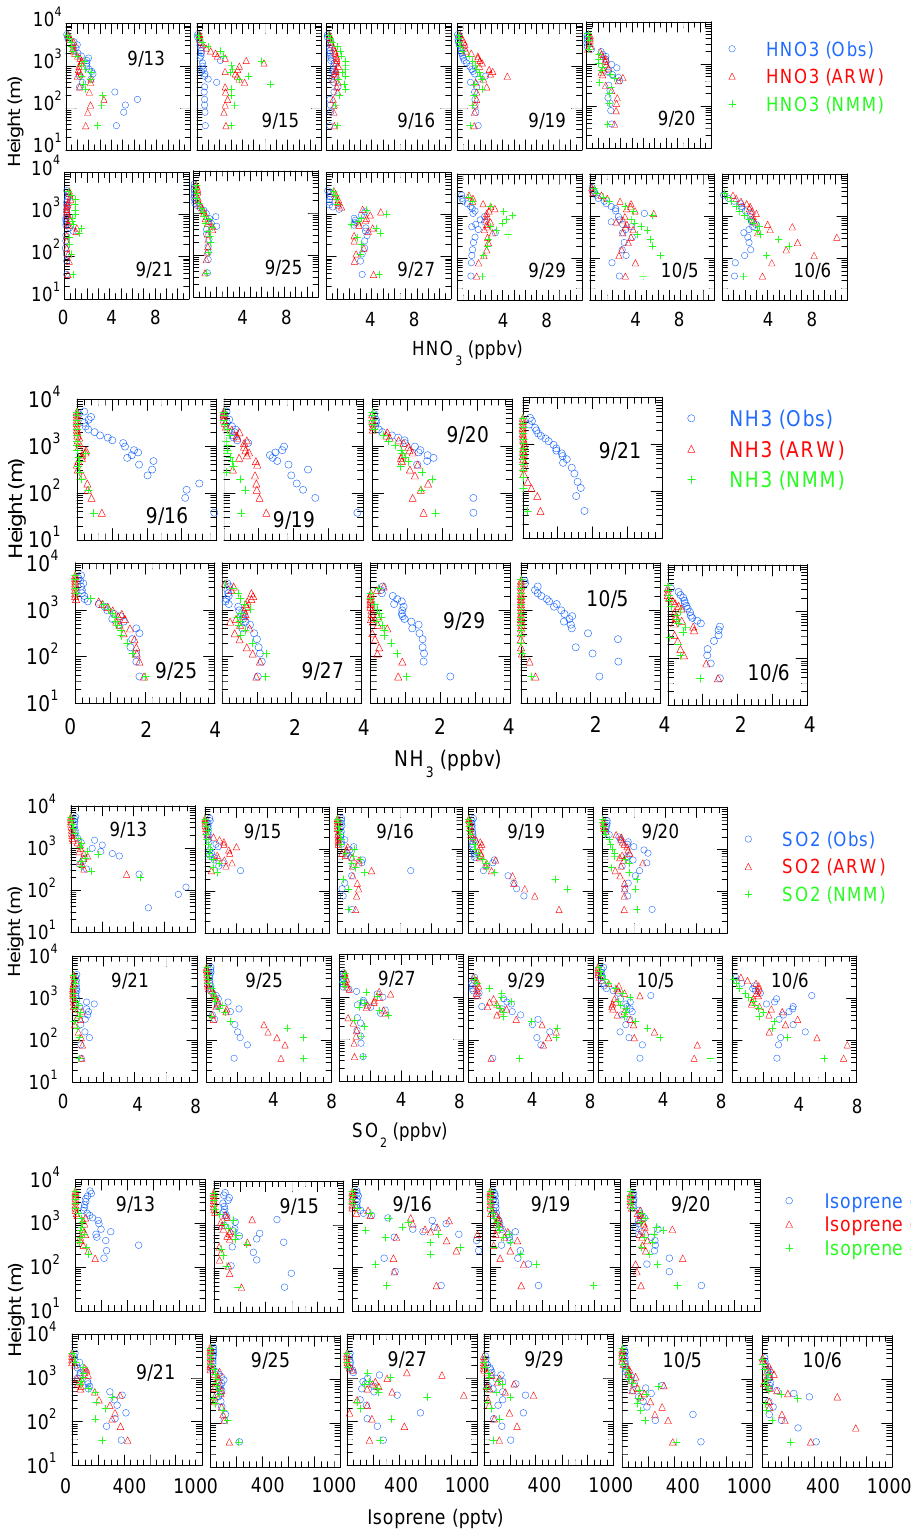
Figure 5. Comparison of composite vertical distributions of observed and modeled Fig. 5. Comparison of composite vertical distributions of observed and modeled (ARW-CMAQ and NMM-CMAQ) HNO 3 , NH 3 , SO 2 , (ARW-CMAQ and NMM-CMAQ) HNO , NH , SO , Isoprene, toluene, terpenes, PM Isoprene, toluene, terpenes, PM 2 . 5 SO 2 − and NH + along the aircraft transects of WP-3 during the 2006 3 3 2 4 4 2- and NH + along the aircraft transects of WP-3 during the 2006 SO 4 4 TexAQS/GoMACCS.